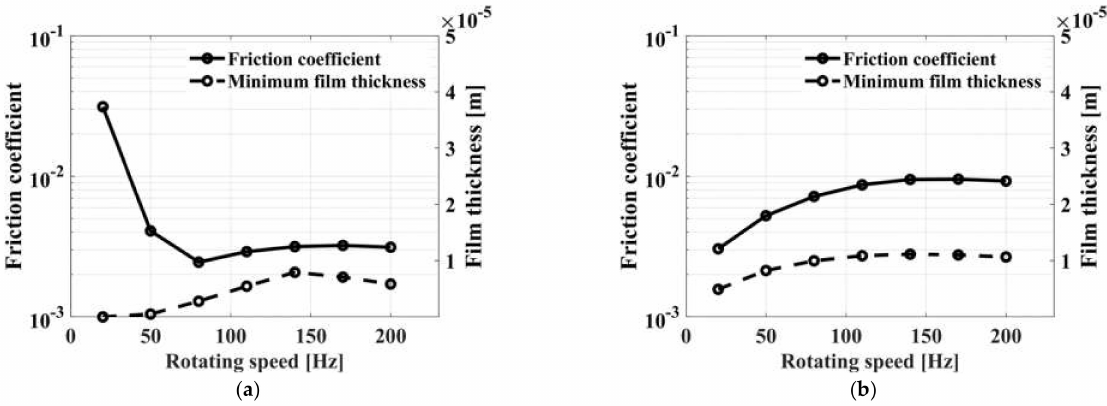
Figure 7. Friction coefficients of an upper bearing ( a ) and lower bearing ( b ) according to operating speed.